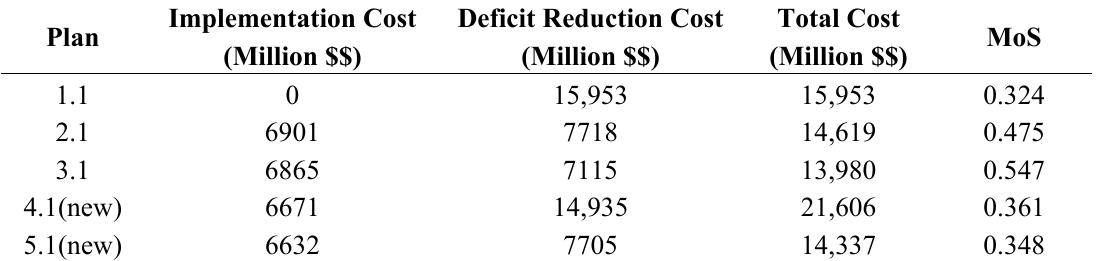
Table 12. Cost and performance evaluations of new management plans. Costs are calculated using the average cost of all demand and climate